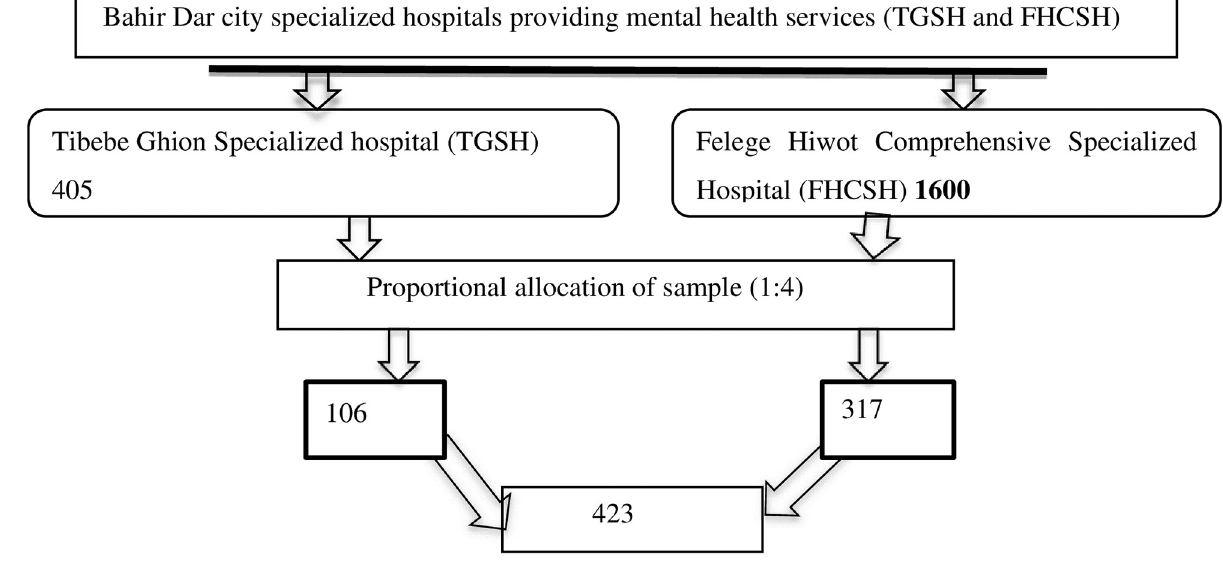
Fig 1. Schematic presentation of proportional allocation of sample among patients with mental illness North West, Ethiopia, 2022.